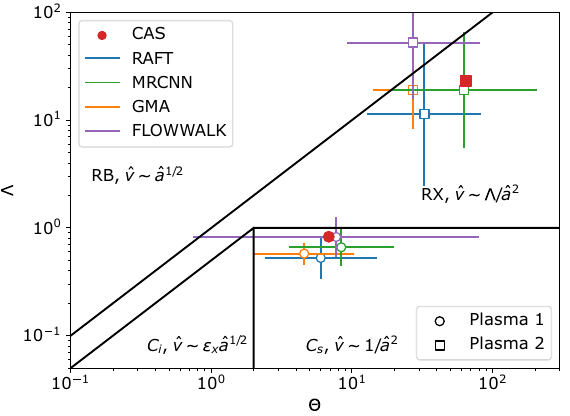
Figure 7. (cid:31) – (cid:31) diagram where (cid:31) and (cid:31) are defined in Eq. (2). The diagram is divided into four blob regimes (RB, RX, C i , and C s ) depending on the relation between the normalized speed ( ˆ v ) and radius ( ˆ a ) of the blobs. Data from two different plasmas (Plasma 1 and Plasma 2) are interrogated by four blob-tracking models (RAFT, Mask R-CNN, GMA, and Flow Walk) and the traditional CAS method, with the locations from each method indicated in the diagram. For these data, the factor ǫ x is 0.5. The bars correspond to the standard deviation of log (cid:31) and log (cid:31)